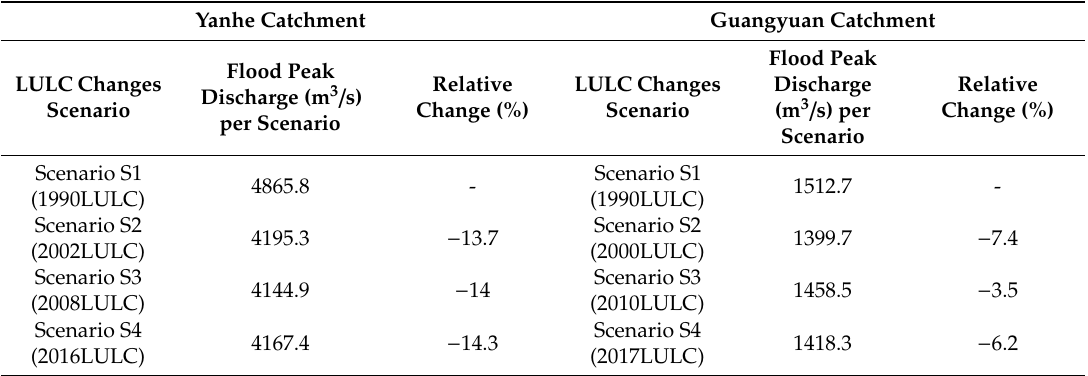
Table 4. Modeling comparison of different LULC changes scenarios for the Yanhe and Guangyuan watersheds.